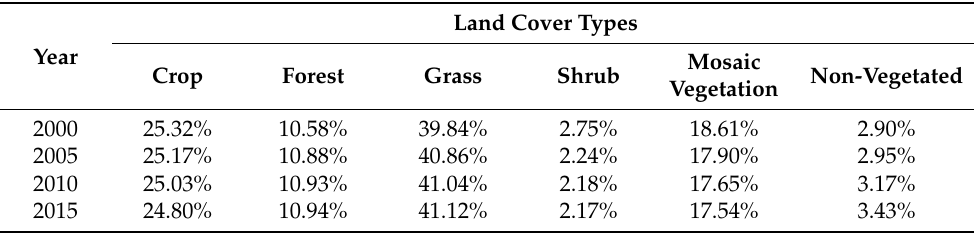
Figure 2. Spatiotemporal change in the LAI on the LP during 2000–2015: ( a ) the spatial distribution of the mean annual LAI; ( b ) the annual average LAI for different land cover types; ( c ) the spatial features of the annual trend of the LAI at the statistically significant level of 0.05; and ( d ) the area percentage of different land cover types with a significant increasing trend ( p < 0.05).